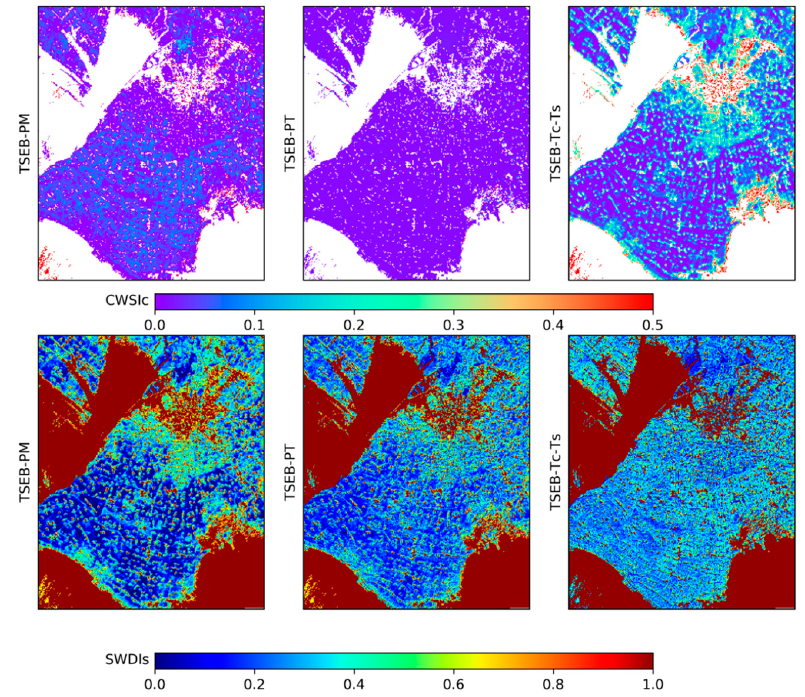
Figure 5. The spatial distribution of CWSI c (first row) and SWDI s (second row) over the Zhangye oasis based on TSEB-PM, TSEB-PT, and TSEB- T C - T S for the satellite overpass time on 10 July 2012. The white areas correspond to the sandy and Gobi desert, and these pixels are masked.